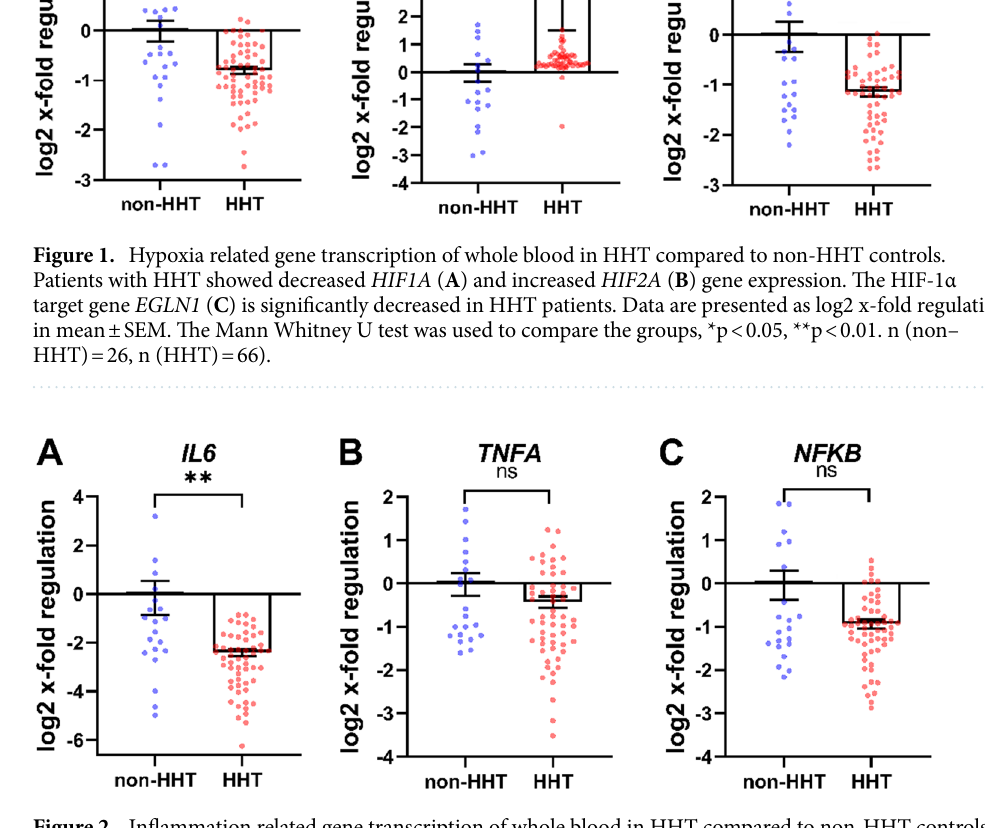
Figure 2. Inflammation related gene transcription of whole blood in HHT compared to non-HHT controls. HIF-1α target gene IL6 ( A ) was significantly downregulated in HHT patients, whereas TNFA ( B ) and NFKB ( C ), the upstream regulator of HIF-1α, showed no difference in gene expression. Data are presented as log2 x-fold regulation in mean ± SEM. Mann Whitney test was used to compare the groups, ***p < 0.001, ns = not significant. n (non–HHT) = 26, n (HHT) =